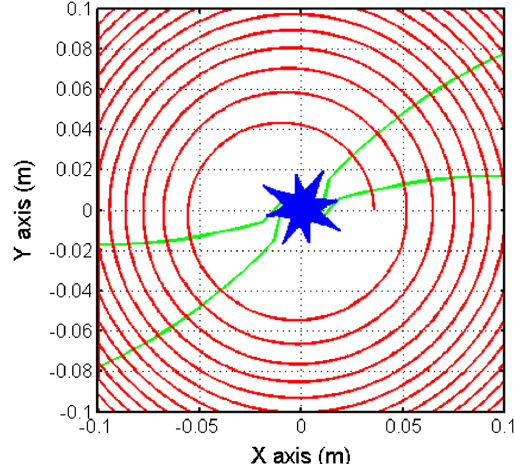
FIG. 5. The single particle trajectory in the first few turns with the central point of the orbit at each time step (shown in blue) in the KIRAMS-430 cyclotron